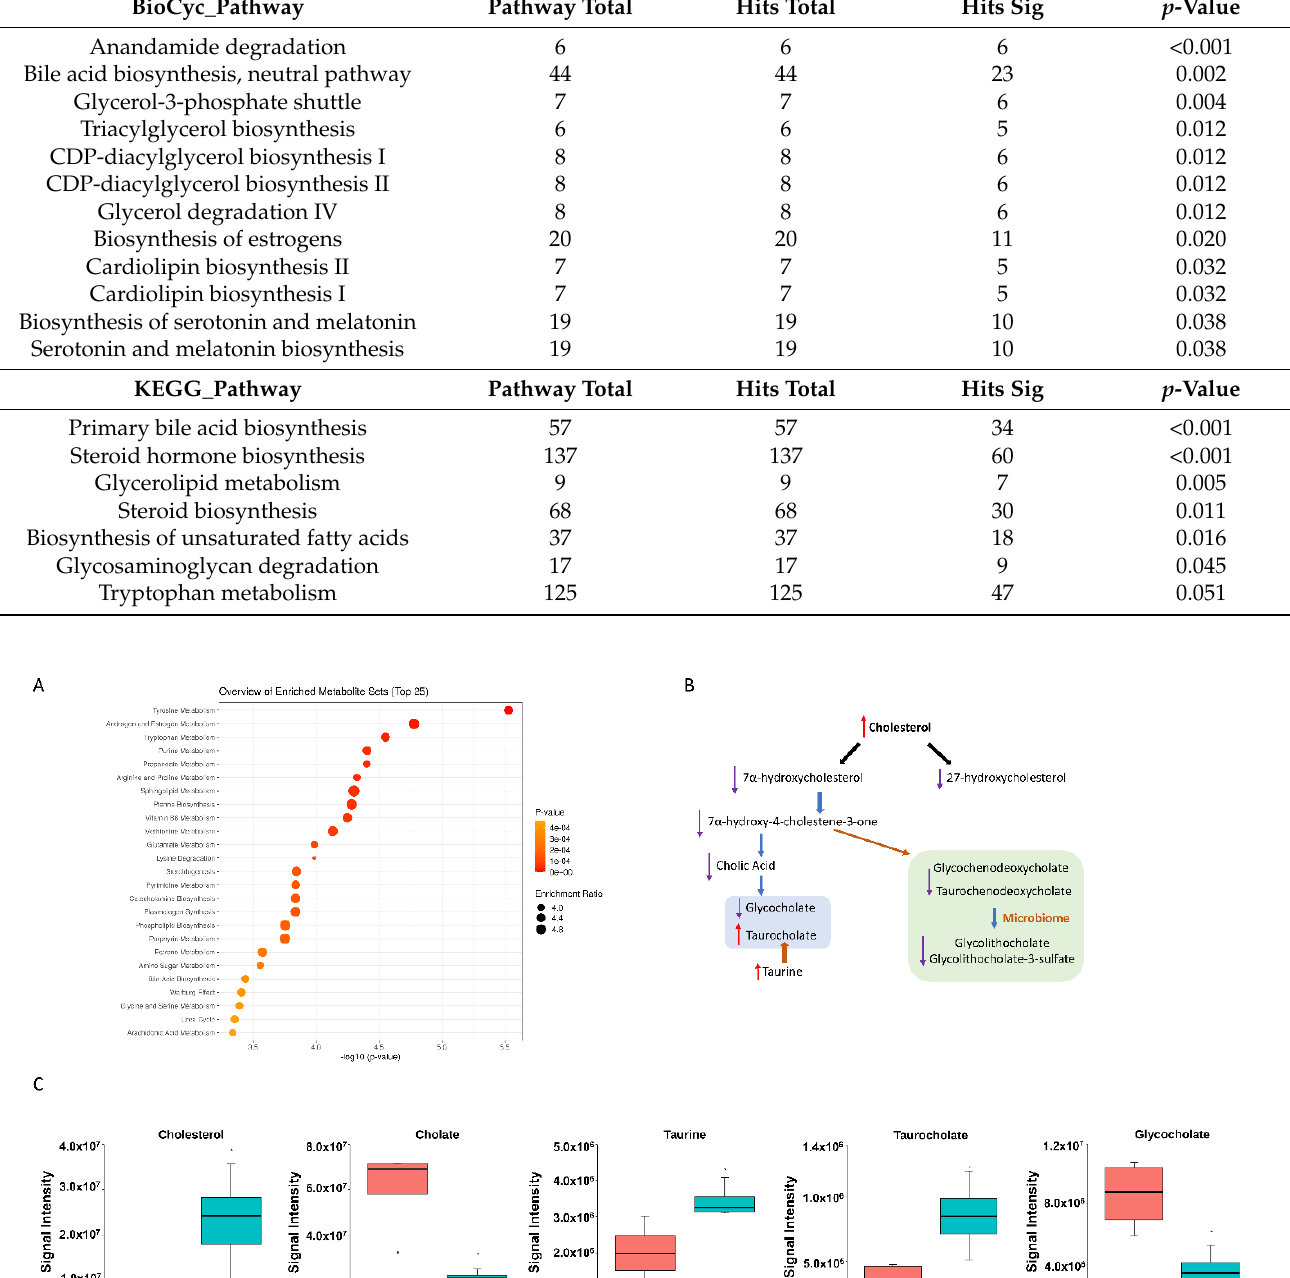
Table 2. Significant pathways hit by the mouse BioCyc database.